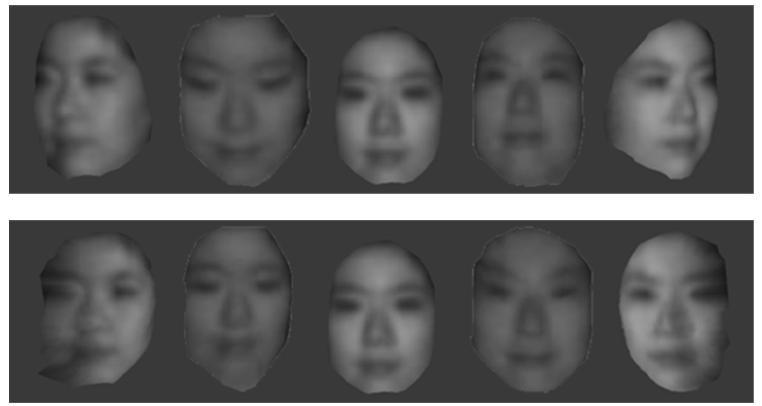
Figure 19. The first row shows 3D near-IR multi-spectrum face data before normalization, and the second row shows normalized 3D near-IR multi-spectrum face